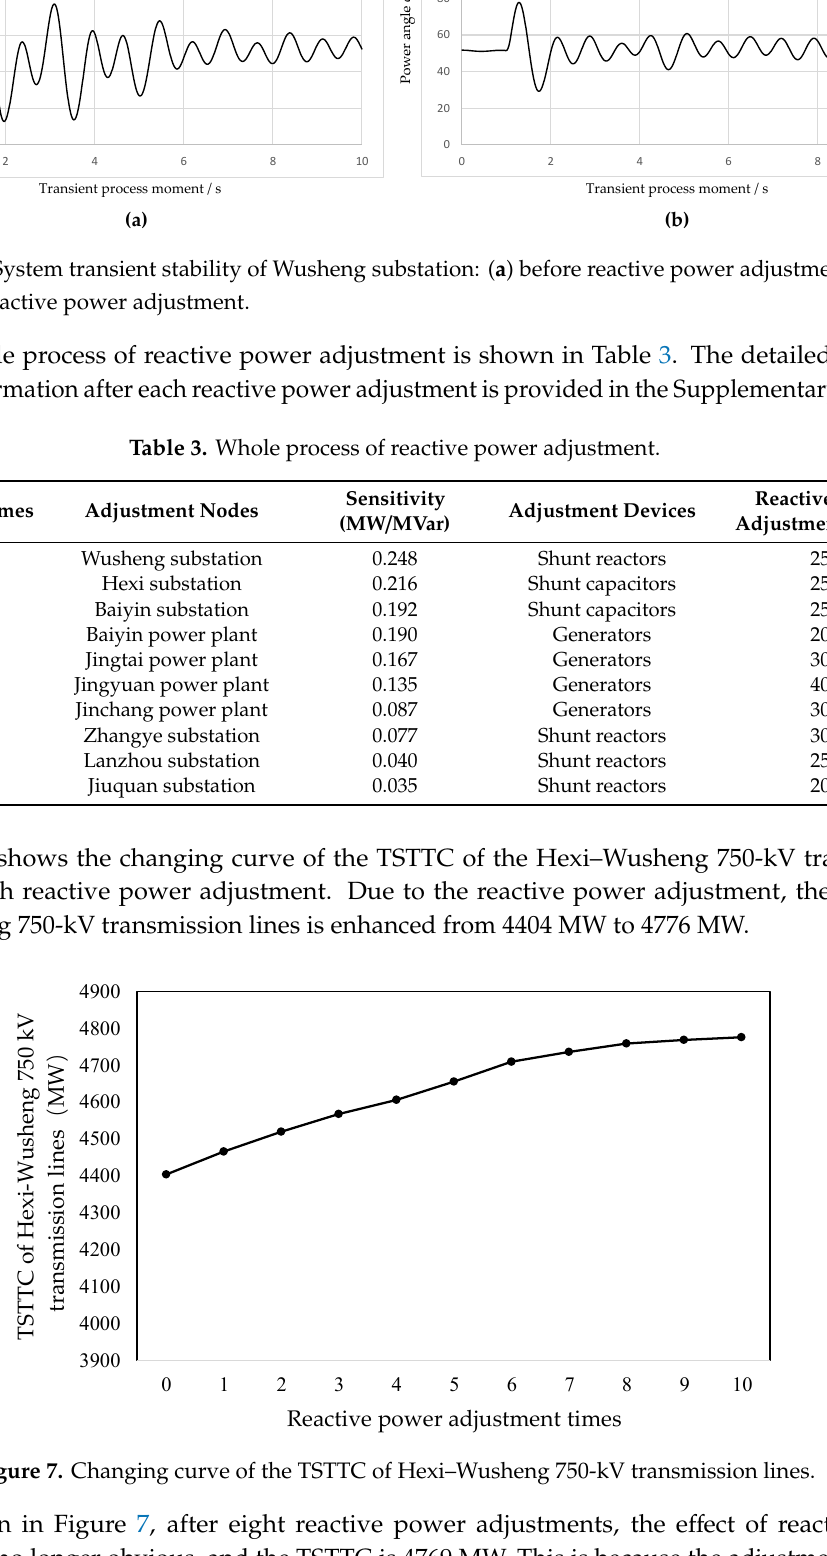
Figure 7. Changing curve of the TSTTC of Hexi–Wusheng 750-kV transmission lines.